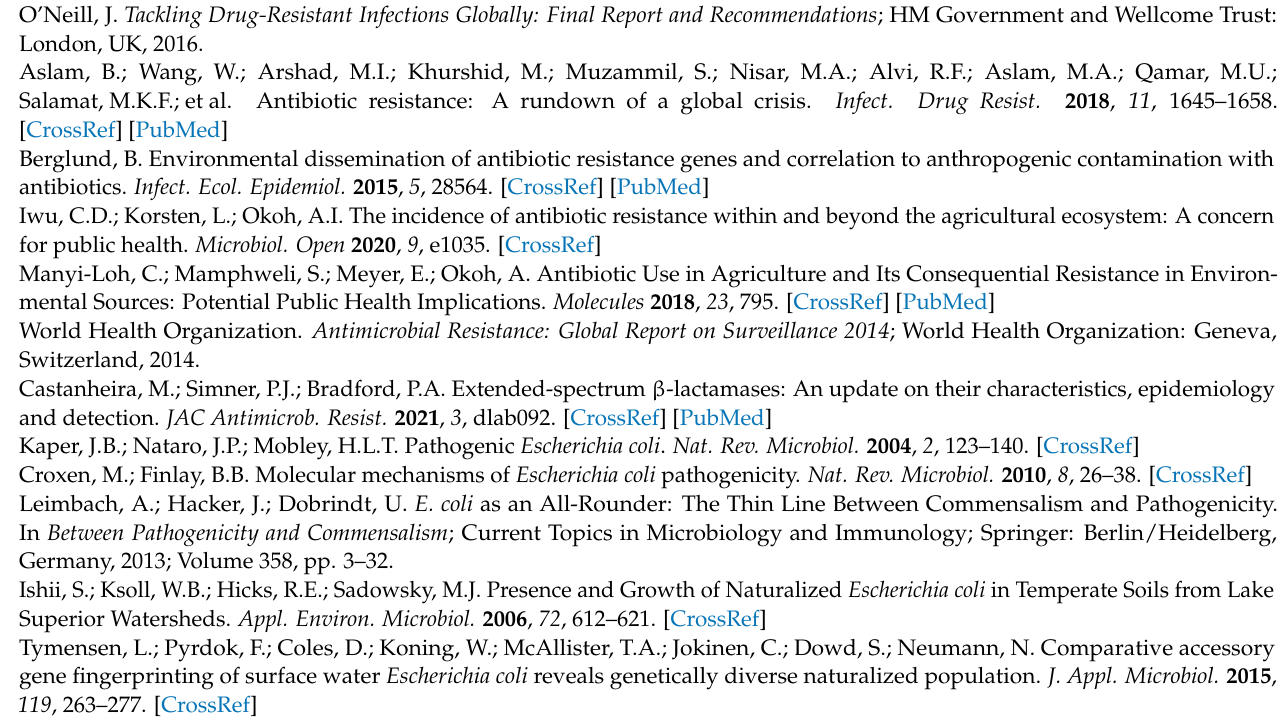
Table S2: Metadata associated with Escherichia coli ST617 genomes from EnteroBase used for cgMLST subtree phylogeny; Table S3: Metadata associated with Escherichia coli ST4 genomes from EnteroBase used for cgMLST subtree